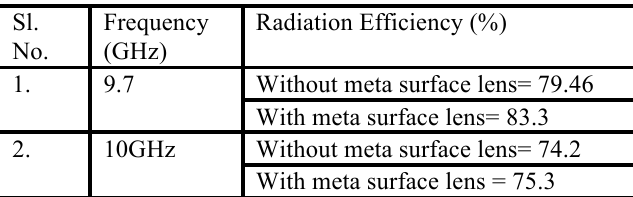
Table I: Radiation efficiency of horn antenna with and without meta